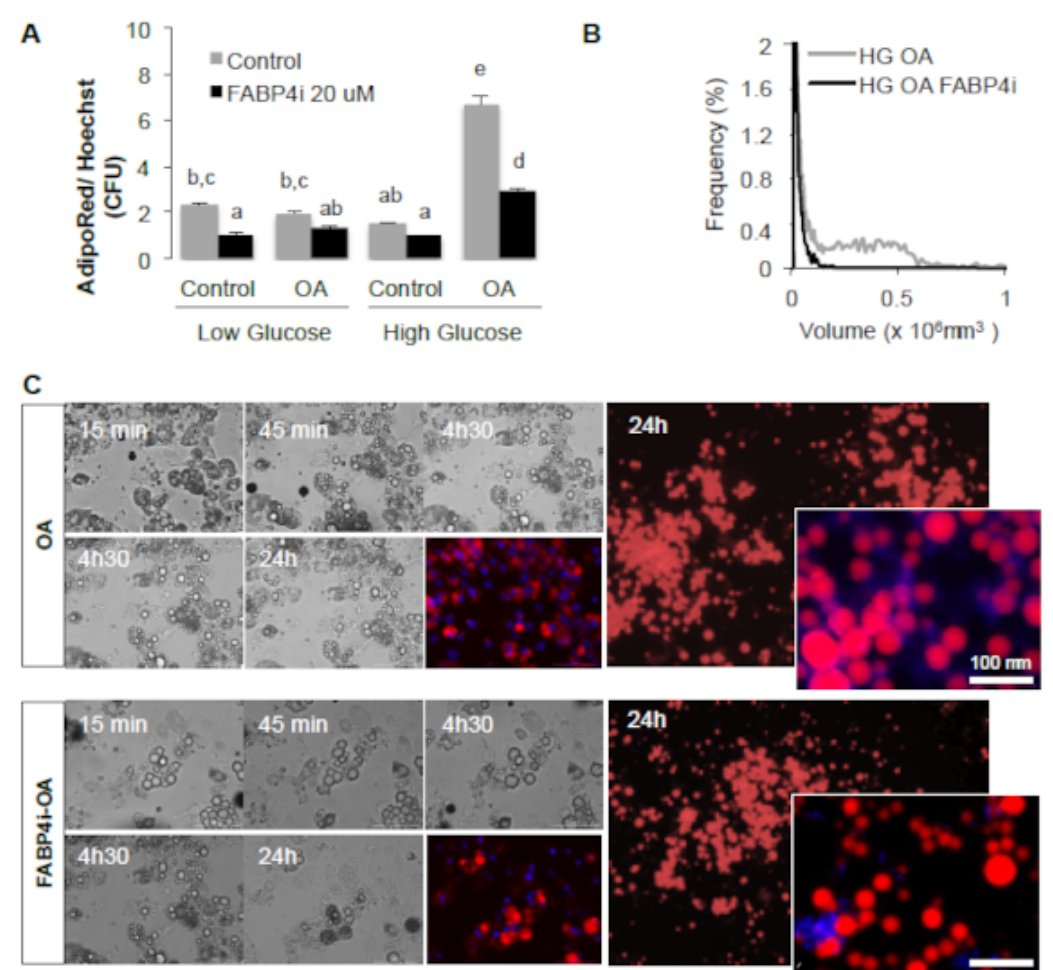
Figure 3. FABP4 is required to induce droplet size increase. ( A ). 3T3-MBX adipocytes treated during 24 h in low glucose (LG, 1 g/L), high glucose (HG, 4.5 g/L) with or without OA (10 µ M) and or inhibitor of FABP4 (FABP4i 20 µ M) then analyzed by image quantification of Adipored and Hoechst (n = 8 biological replicates). ( B ) Multisizer cell size distribution validates the inhibitory effect of FABP4i on cell size increase (n = at least 5000 cells). Significant differences are represented by letters (ANOVA test p -values p < 0.05). ( C ) Real-time imaging in high glucose media then merged AdipoRed (red) and Hoechst 33258 (blue), left panel, and representative images at × 4 and × 20 (right